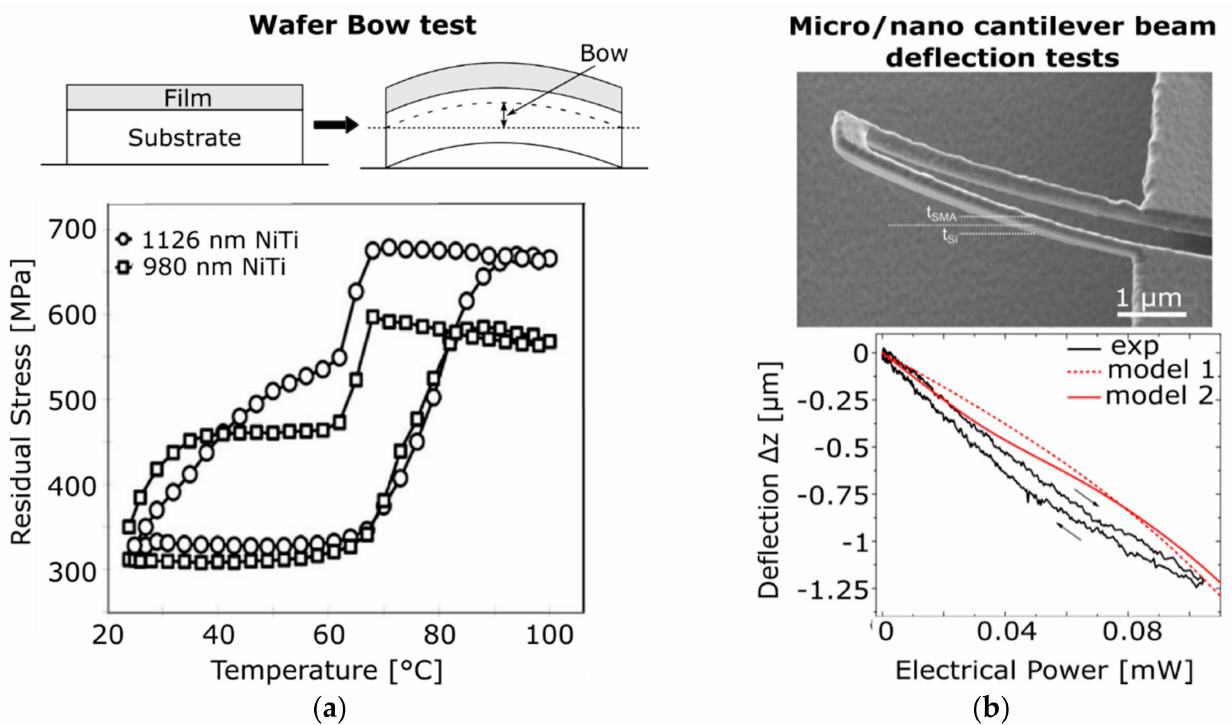
Figure 7. Bending tests of miniaturized SMA samples: ( a ) Wafer bow tests reproduced from [137] with permission from Elsevier 2019; ( b ) Nano cantilever beam deflection test reproduced from [141] with permission from Springer